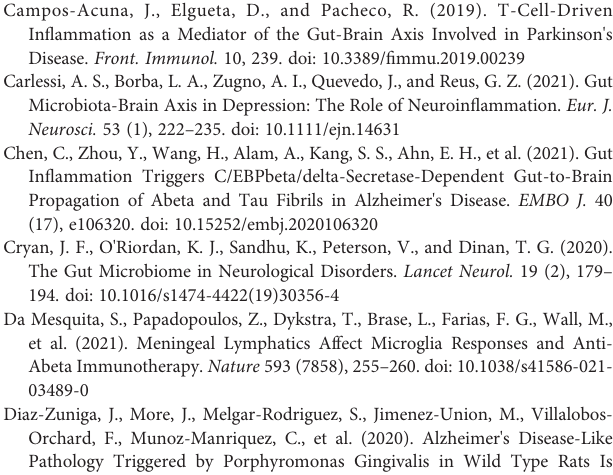
Supplementary Figure 1 | Physiological measures of body weight after the fi rst Pg administration. Supplementary Figure 2 | (A) The composition of bacteria at the Class level between the Pg-administered and control group. (B) The composition of bacteria at the Genus level between the Pg-administered and control group. (C) Venn diagrams are used to show the number of common or unique OTUs between Pg and control group. Each circle represents the number of OTUs for each group. The overlapping area represents the shared OTUs in both groups. (D) Bar plots for phylum, class, order, family and genus that showed differences in the Pg- administeredandcontrolgroup.n=3,datawereshownasmeans±SEM.* p ≤ 0.05; ** p ≤ 0.01. Supplementary Figure 3 | Histological aspects of ileum and colon. (A) Representative histological section of ileum. Rectangular box represents the gland destruction in the gut and in fl ammatory cells in fi ltration. (B) Representative histological section of colon. Scale bar, 200 m